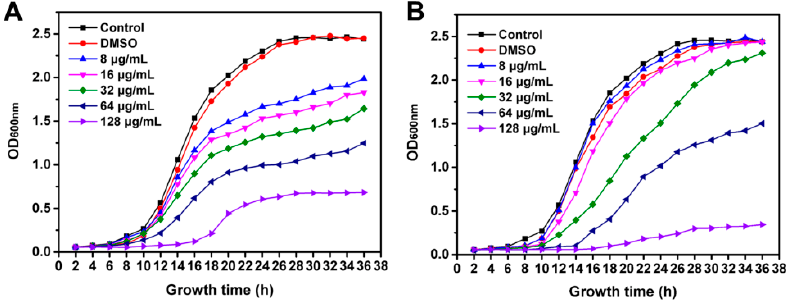
Figure 3. The bacterial growth curve of R. solanacearum in the presence of resveratrol ( A ) and coumarin ( B ) at concentrations ranging from 8 to 128 μ g/mL. DMSO was indicated as a negative control and Control was used as bacterial cells treatmented with sterile water.